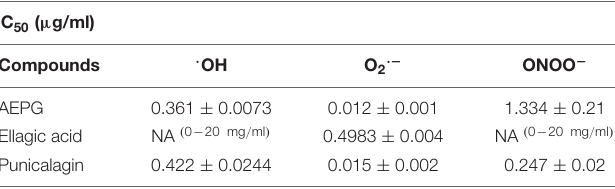
TABLE 2 | Scavenging capacity of different compounds against hydroxyl radical (OH), superoxide anion (O 2 − ), and peroxynitrite (ONOO − ).